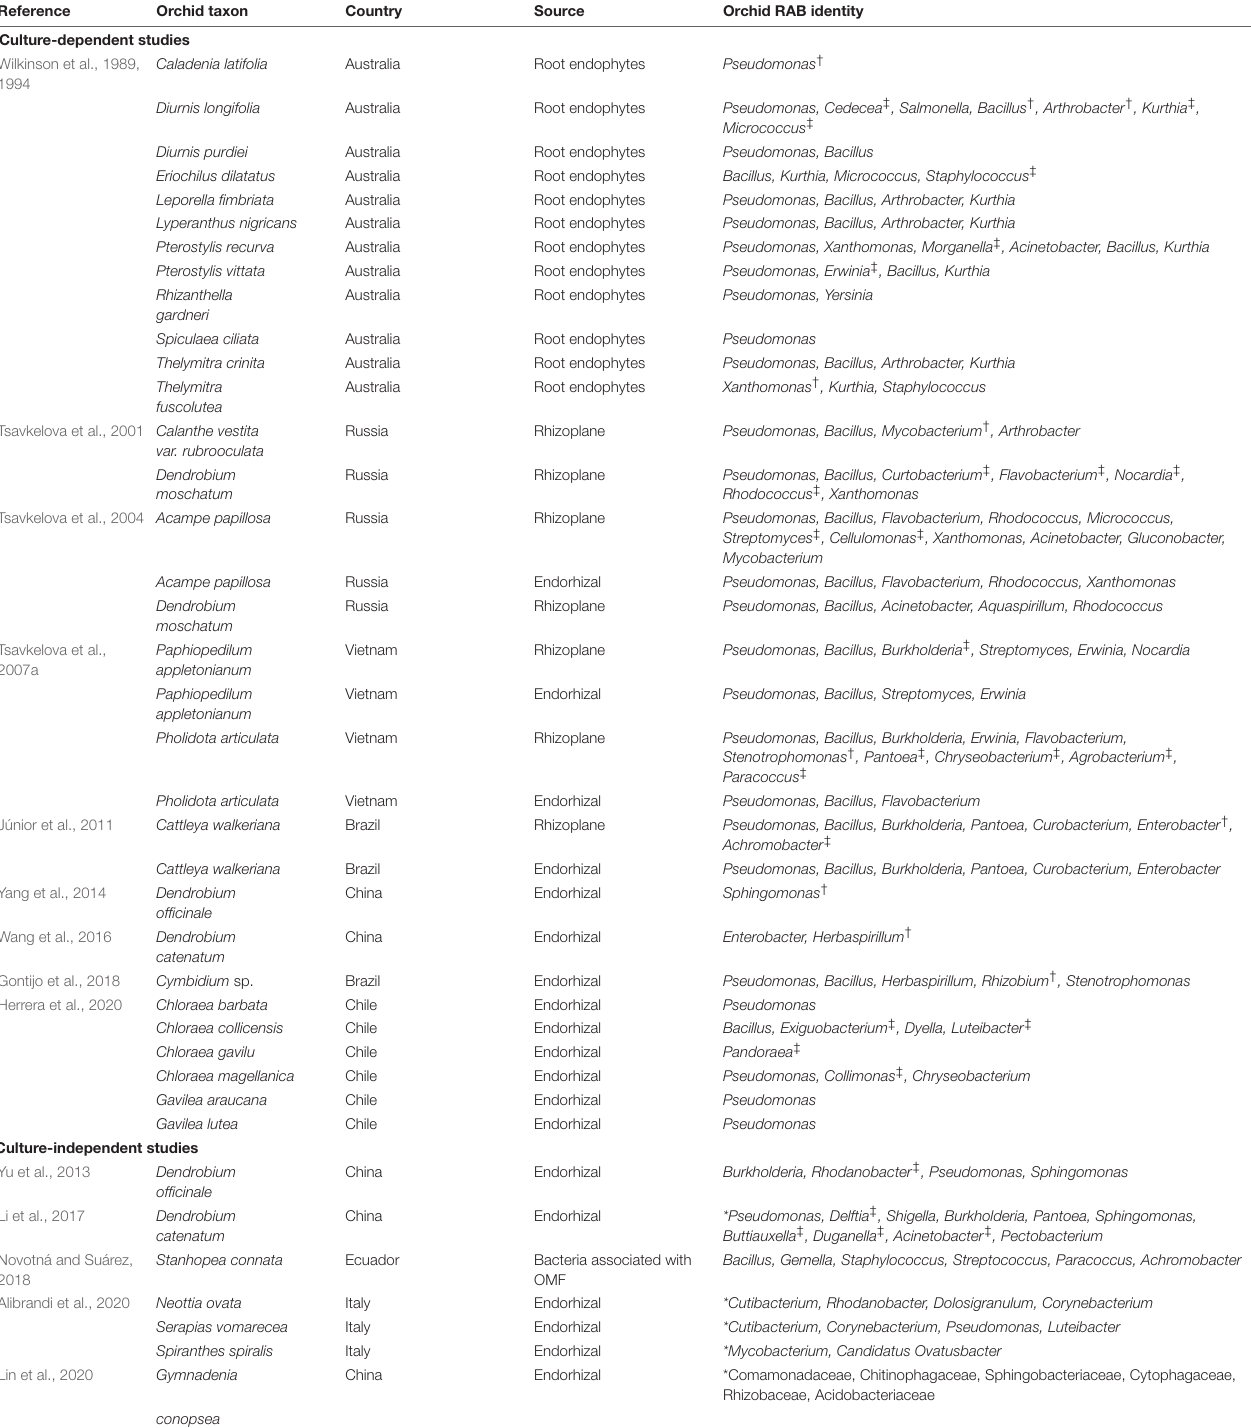
TABLE 1 | A summary of the genera or families of orchid Root Associated Bacteria (RAB) identified either by culture-dependent or culture-independent